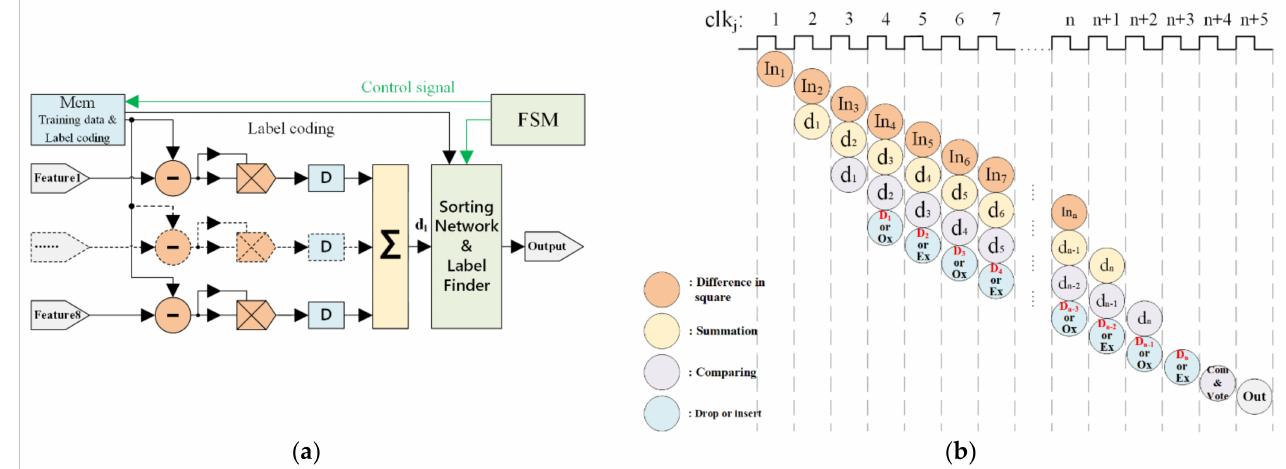
Figure 7. The k-NN algorithm implementation. ( a ) Block diagram of k-NN. ( b ) Scheduling of the k-NN